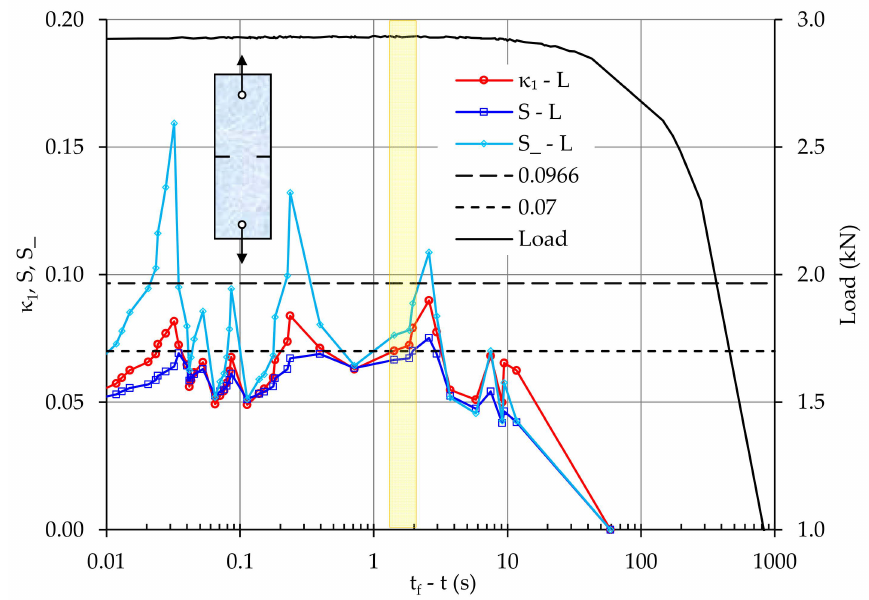
Figure 8. The temporal evolution of the natural time parameters κ 1 , S, S_ and that of the load applied, for the sensor close to the notch from which fracture started with delay.